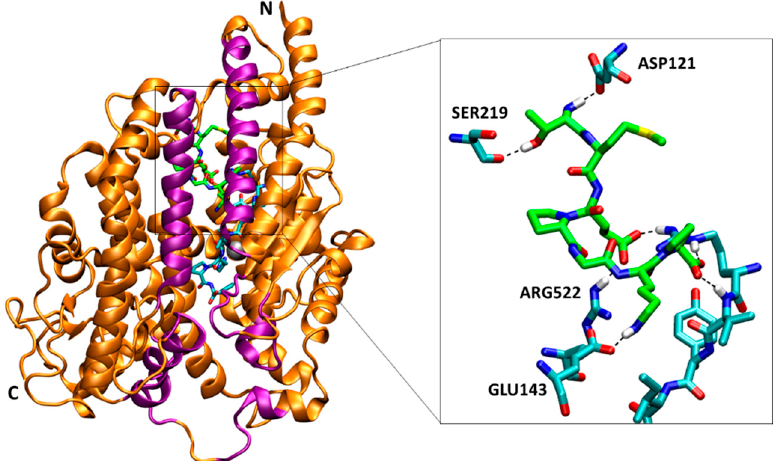
Figure 5. The binding site of the SPI (green carbon) next to AngII (cyan carbon) in the cleft of sACE. sACE is represented by orange ribbons (purple lips), and the zinc ion in the active site is represented by a gray sphere. AngII and ACE binding site are represented by sticks, and carbon, nitrogen, oxygen, sulfur and hydrogen atoms are colored by cyan, blue, red, yellow and white, respectively. SPI is represented by sticks, and carbon atoms are colored by green. Only residue numbers of sACE are shown in the inset figure for clarity. The snapshot was taken at 200.38 ns.